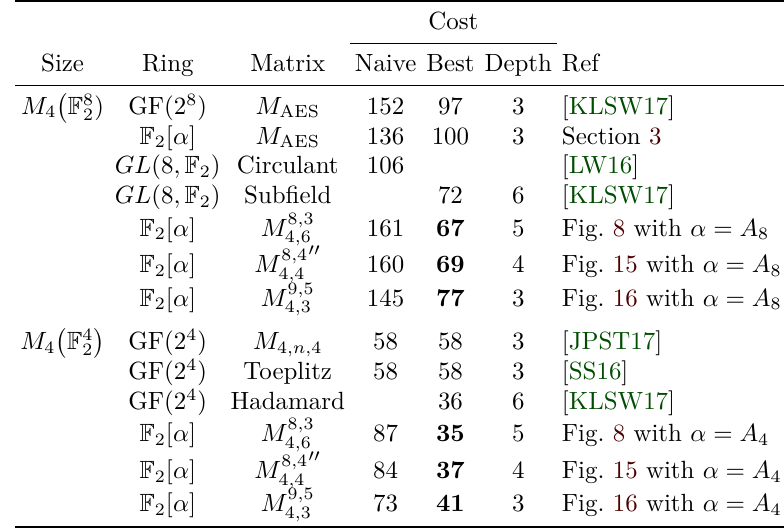
Table 1: Comparison of the lightest MDS matrices ( A 4 is the companion matrix of X 4 + X + 1, A 8 is the companion matrix of X 8 + X 2 + 1 = ( X 4 + X + 1) 2 ).